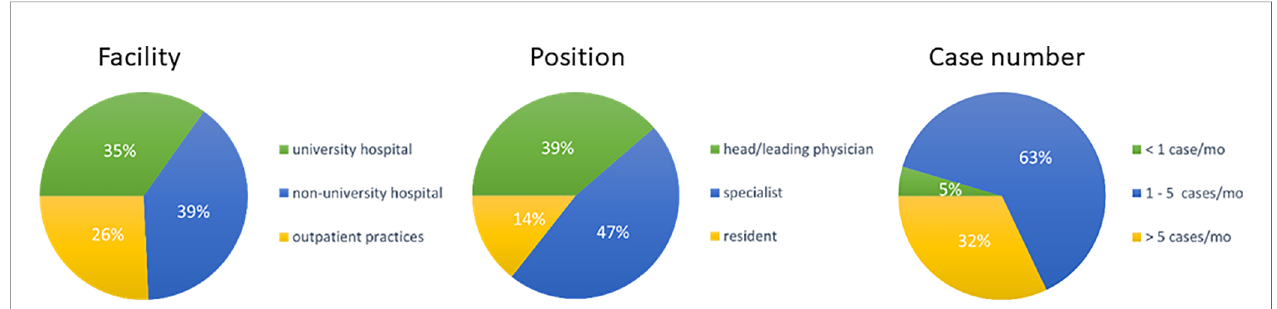
FIGURE 1 | Pie charts for the type of responders ’ facility (n=132), responders ’ position (n=132) and treated cases per month (n=) indicated as percentage of responders. (mo,